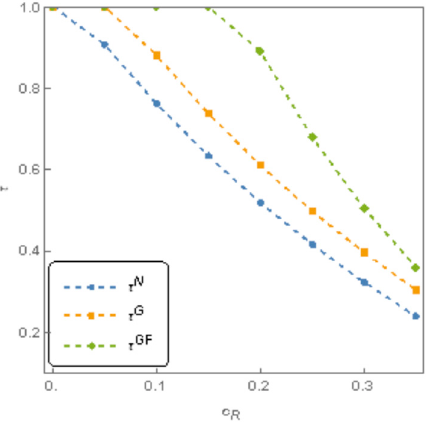
Figure 2. The recycling rates under different development models.